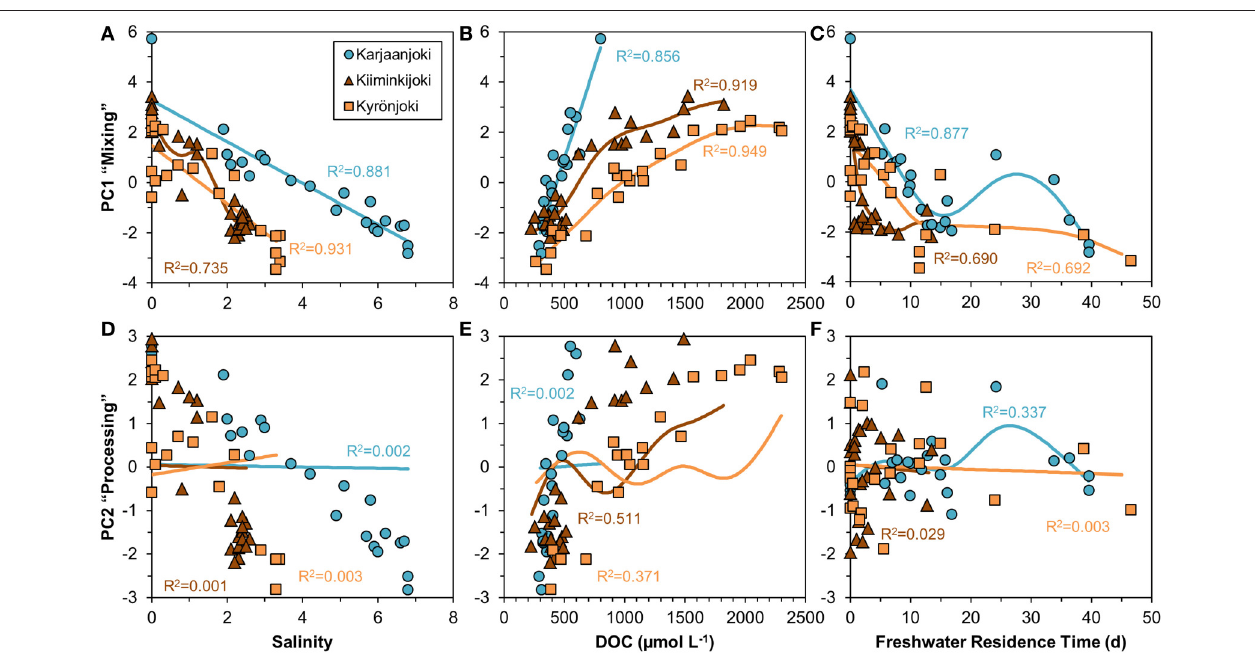
FIGURE 6 | Relationships of the two first principal components versus salinity, DOC concentration and freshwater residence time investigated by a non-parametric GAM (solid line). (A–C) Principal component 1 (“Mixing”). (D–F) Principal component 2 (“Processing”). Freshwater residence time in the Karjaanjoki estuary is divided by 10 for the figure to allow comparison with other two